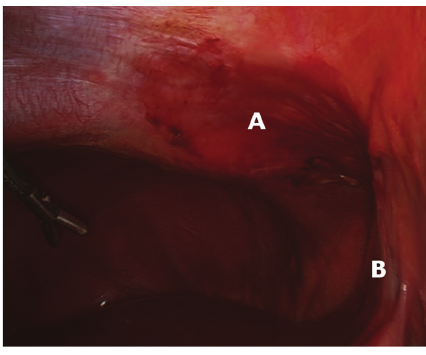
Figure 2: Intraoperative image showing inflammatory changes to the anterior abdominal wall (A) located adjacent to the falciform ligament